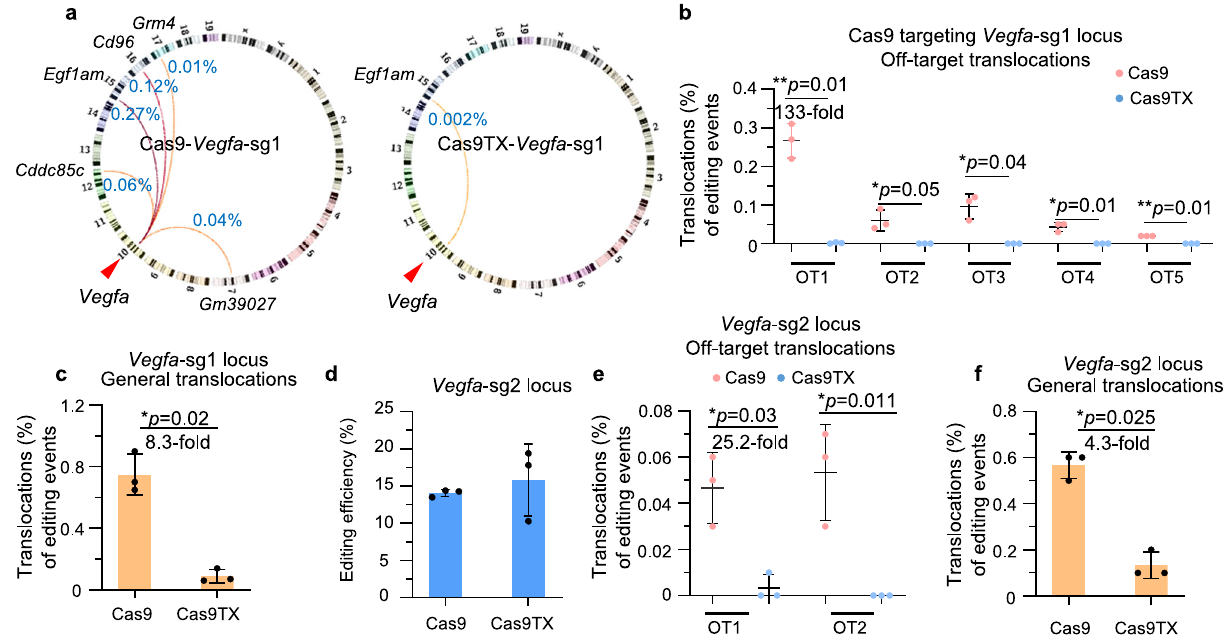
Fig. 3 | Cas9TX nearly eliminates chromosomal translocations in vivo. a Circos plotindicatingtranslocationsamongon-targetandoff-targetsof Vegfa -sg1inCas9- and Cas9TX-treated mouse models of AMD detected by PEM-seq. b and c . Per- centages for off-target translocations ( b ) and general translocations ( c ) cloned from Vegfa -sg1 in Cas9- and Cas9TX-treated mouse models of AMD detected by PEM-seq. Mean ± SD from three biological replicates. Two-tailed t -test, * p <0.05,